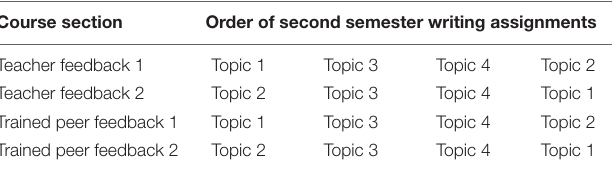
TABLE 2 | Order of writing topics in each course section/condition during the second